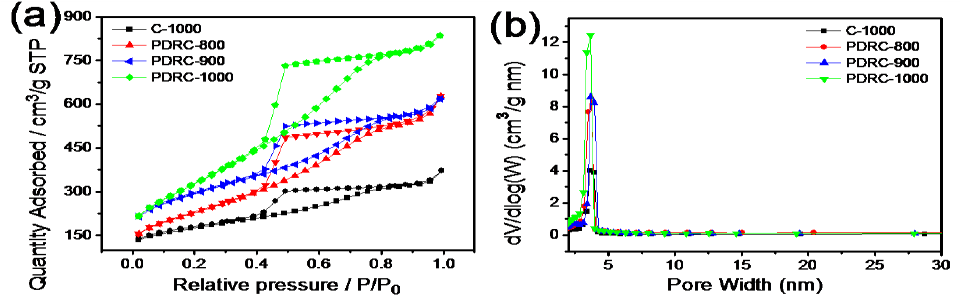
Figure 3. ( a ) Nitrogen adsorption–desorption isotherms and ( b ) pore size distributions of C-1000, PDRC-800, PDRC-900 and PDRC-1000.